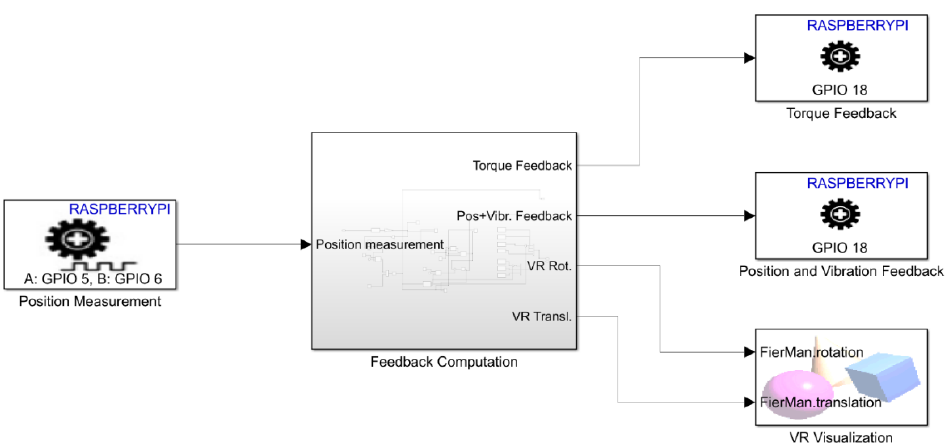
Figure 14. The basic block diagram of the operation of the haptic equipment made in Matlab soft- ware.